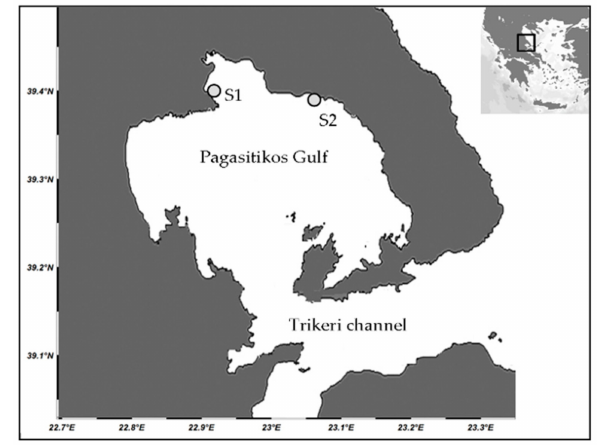
Figure 1. Map of the study area indicating the location of the sampling stations (S1 and